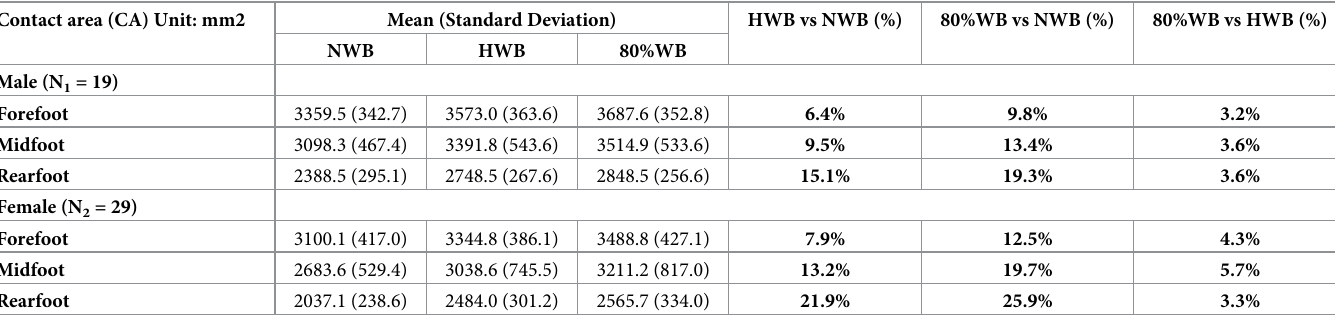
Table 4. ANOVA analysis and change percentage of contact area for NWB, HWB, and 80%WB groups. Contact area (CA) Unit: